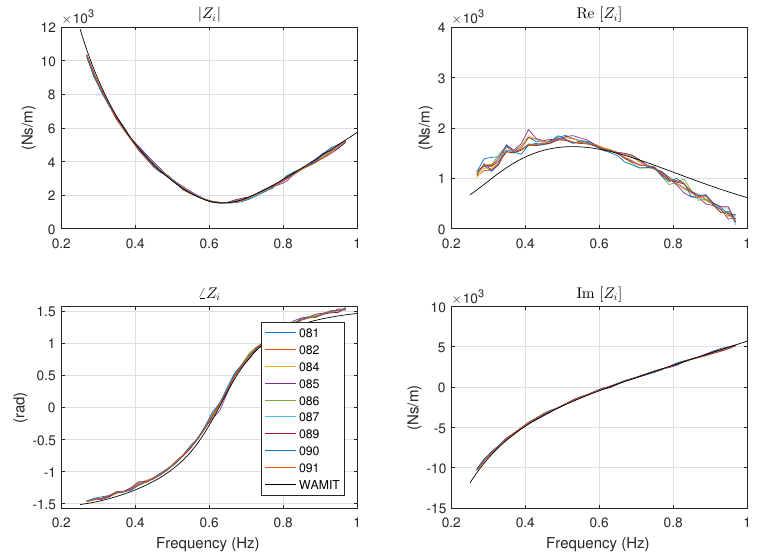
Figure 15. By using the linearized equivalent damping in (12), the offset in the real part of the intrinsic impedance has been significantly